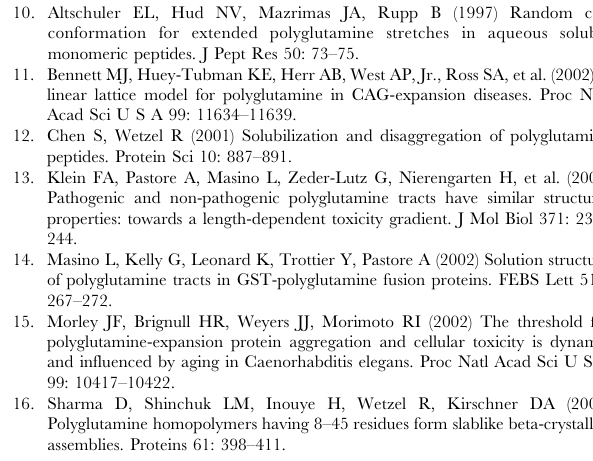
Figure S1 Correlation between pathogenic allele size deter- mined by clone sequencing and fragment sizing of clones. Mean pathogenic allele size as determined via clone sequencing was compared to diagnostic fragment sizing of clones ( n = 100).